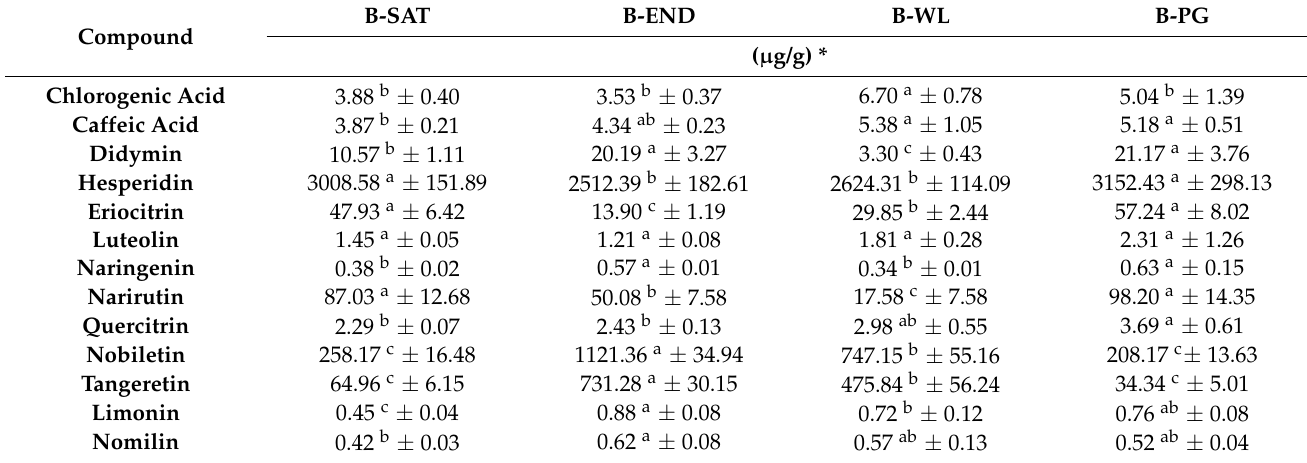
Table 2. Identified phytochemicals in bearing leaf of ‘Ellendale’ (B-END), ‘Willowleaf’ (B-WL), ‘Page’ (B-PG), and ‘Satsuma’ (B-SAT) and their concentration expressed in µ g/g of dried